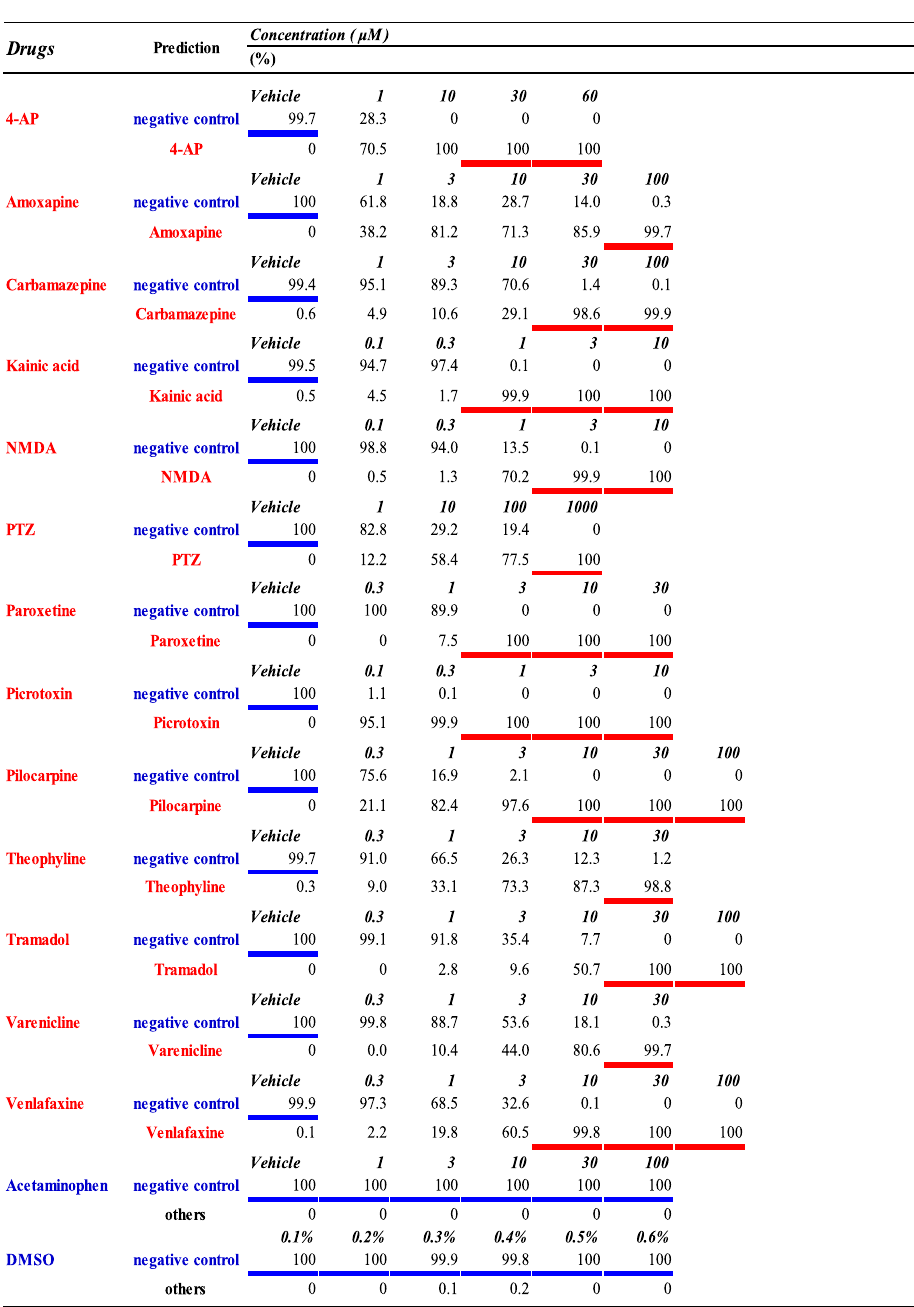
Table 4. Probability of drug name in each concentration data predicted by AI. The underlining shows the concentration data used for learning the drug name (red), and the negative control